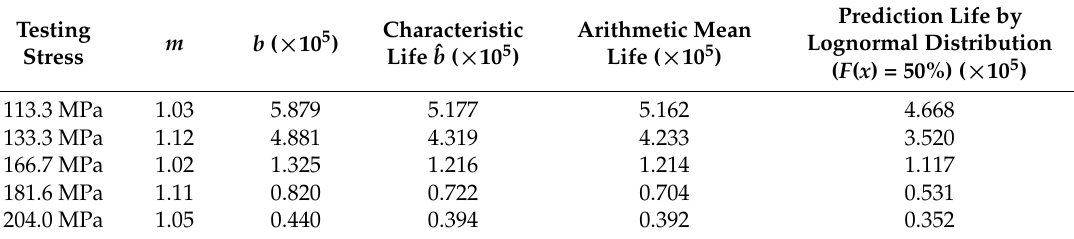
Table 3. Statistical parameters of fatigue lives under different stress amplitudes in